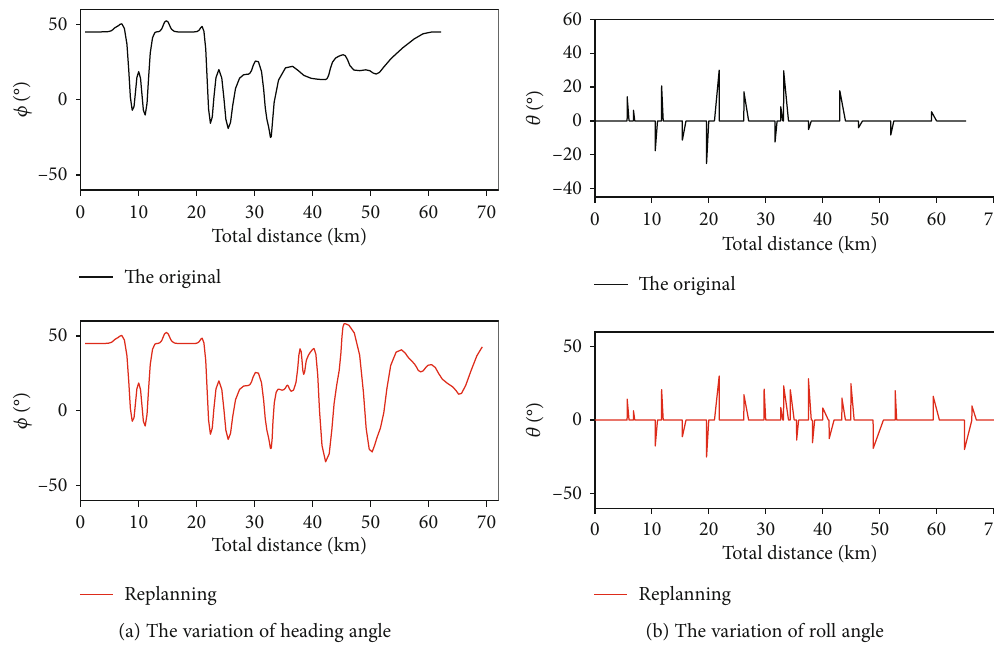
Figure 9: The variation of attitude angle employed by improved A-Star algorithm in the second